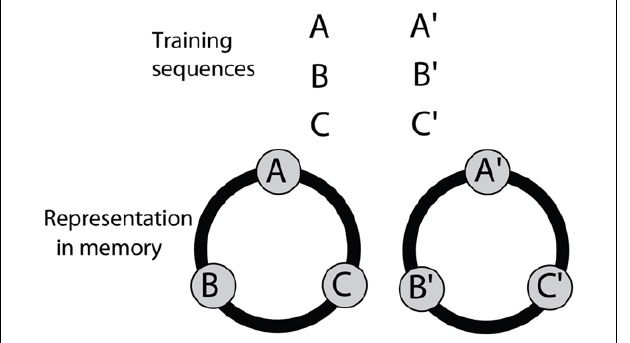
FIGURE 9 |A model for associative grouping, derived from the results of the symbolic-delayed-match-to-sample experiments. Details in